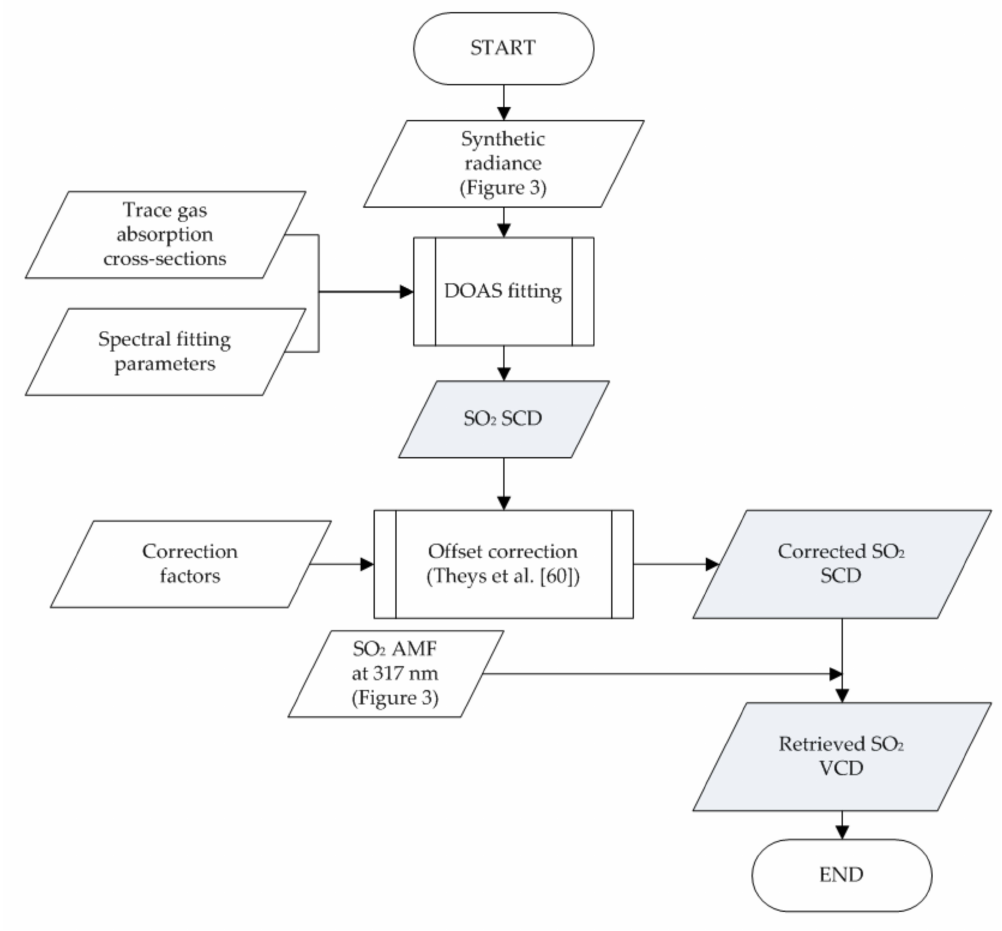
Figure 4. Flowchart of SO 2 VCD retrieval using synthetic